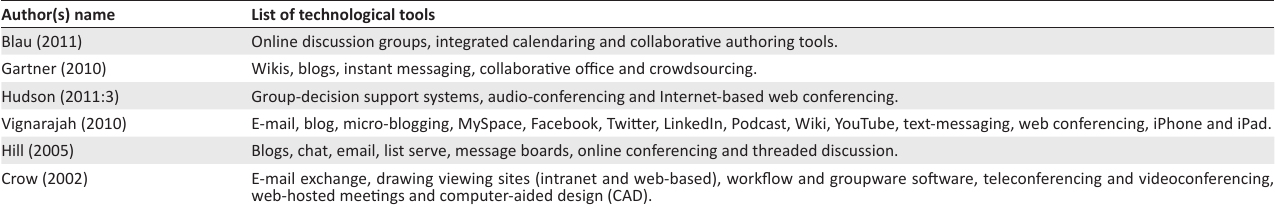
TABLE 1 : Technology used for